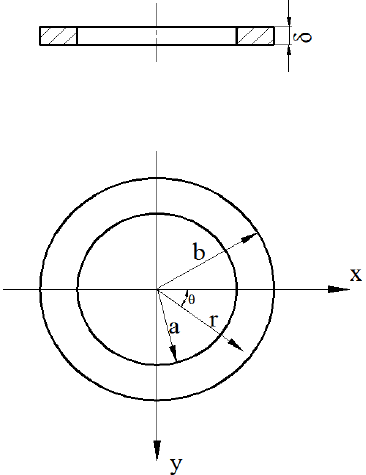
Figure 6. Schematic diagram of the ring.